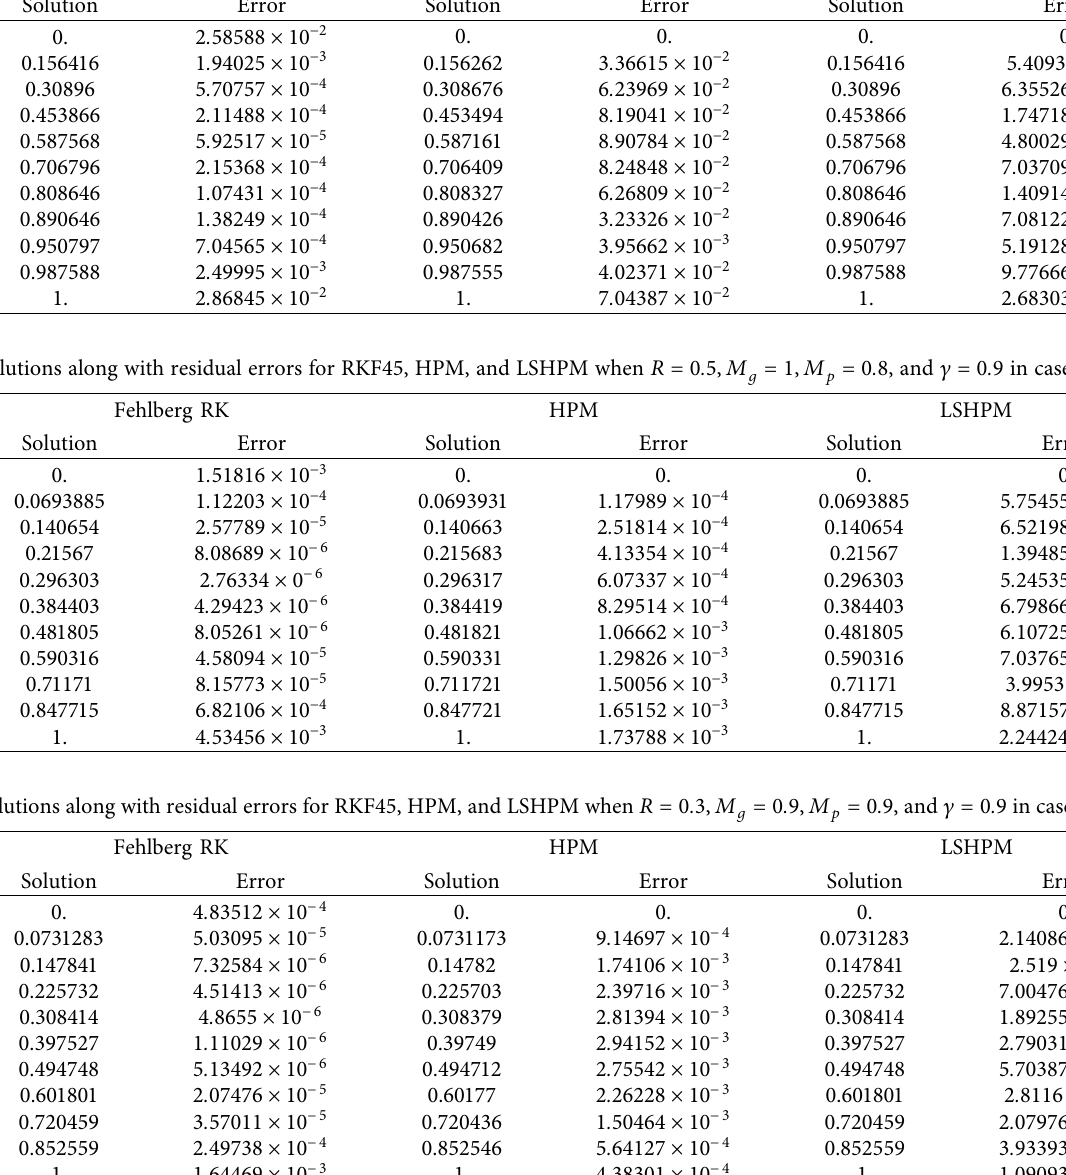
Table 2: Solutions along with residual errors for RKF45, HPM, and LSHPM when R � 1 ,M